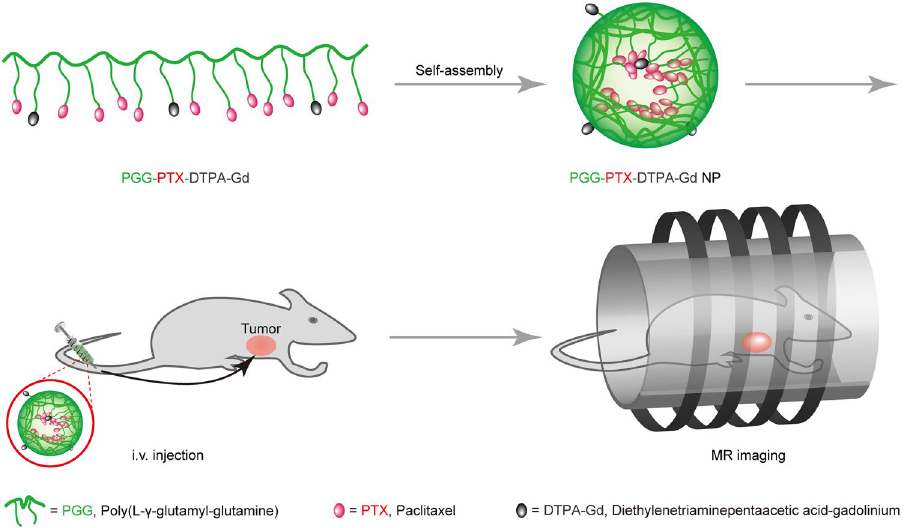
Figure 1. Schematics of the MR imaging of the